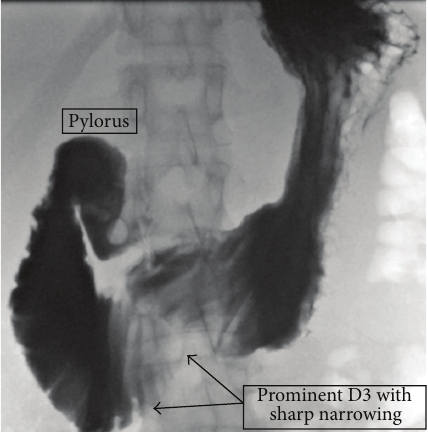
Figure 6: Antero-posterior view of contrast study demonstrating a dilated D3 with sharp narrowing mid